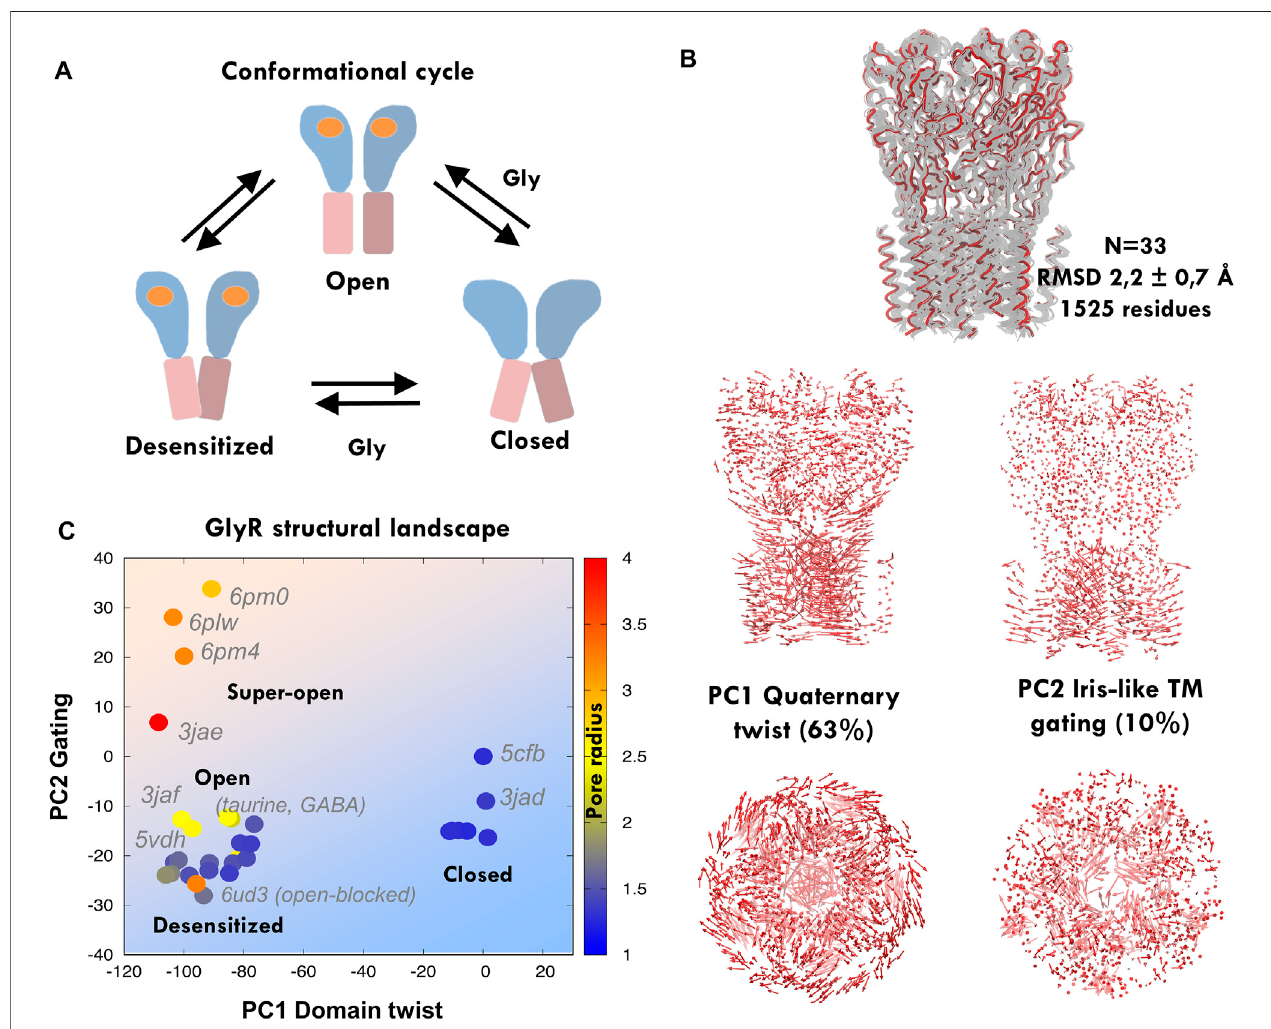
FIGURE 2 | Principal component analysis and elastic network modeling of GlyR. (A) Simpli fi ed scheme of the conformational cycle depicting the three main meta- stable states: closed, open, and desensitized, with ECD in blue and TMD in pink depicting blooming and open and closed pore TM2 orientations (see the main text). (B) ExperimentalGlyRensemblecontaininghumanandzebra fi shstructures( top )andprincipalcomponentsfromtheGlyRensemble( bottom ):themajorcomponenttracks theanticorrelatedECD-TMDtwist,whilethesecondcapturesiris-likeporegating. (C) ProjectionsoftheGlyRensembleontoPC1-2,withstructurescoloredaccording totheirradius. Notehow structuresseparateontothreeclusters correspondingtotheassignedfunctionalstates, withtheonlyexception ofopenblocked 6ud3. Thehuman closed structure 5cfb is used as a reference and thus projects at the origin. See related Supplementary Figure S1 , Supplementary Table S1 .